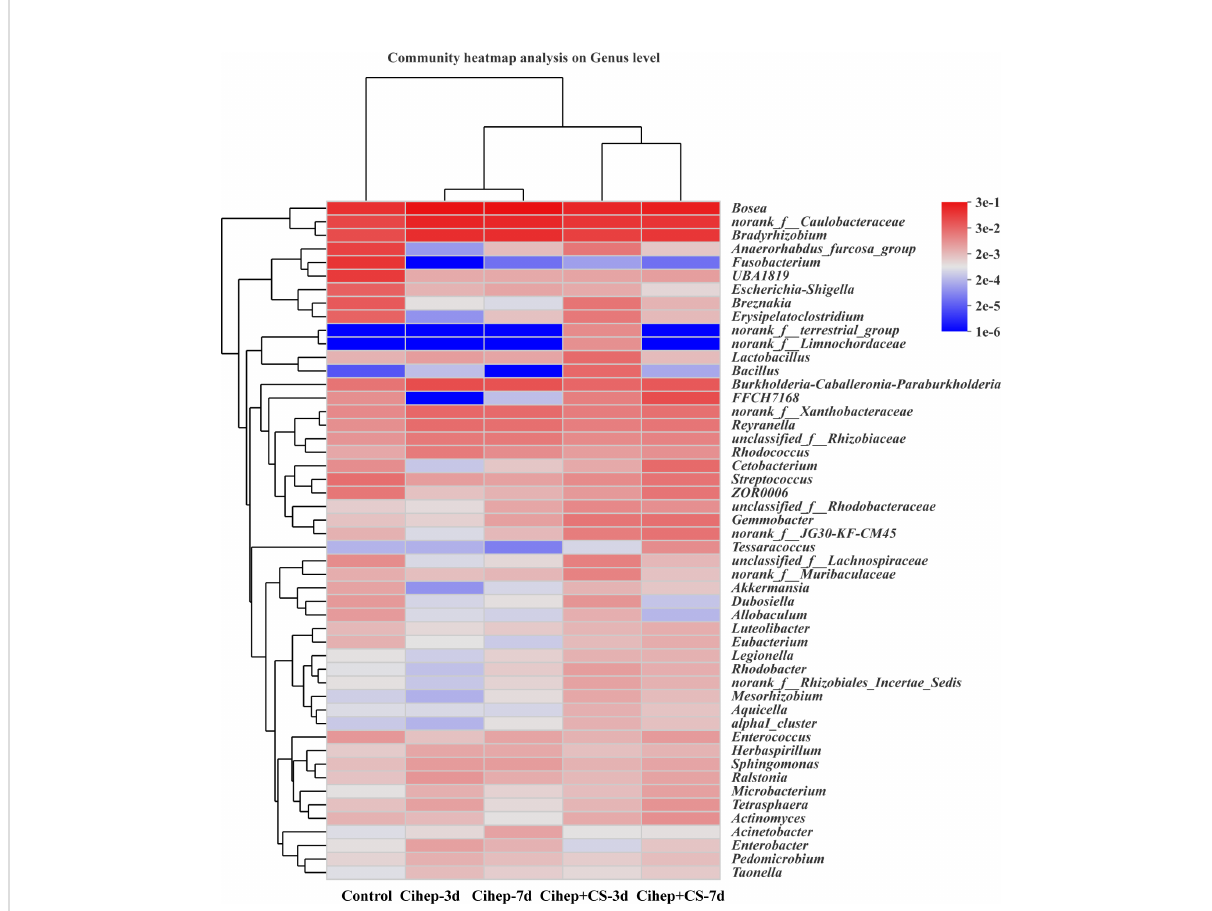
FIGURE 8 Heatmap of hierarchy cluster results for the relative abundance of all samples at genus level. The sample information is shown along the horizontal axis. Annotations are shown along the vertical axis on the right. The genera clustering tree is shown along the vertical axis on the left. The sample clustering tree is shown above. The color represents the Z-Score, which is the standardized relative